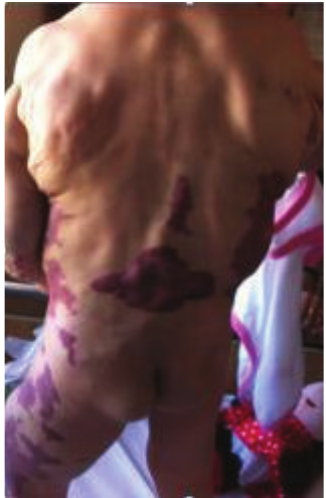
Figure 3: Port-wine stain over the back and thigh.